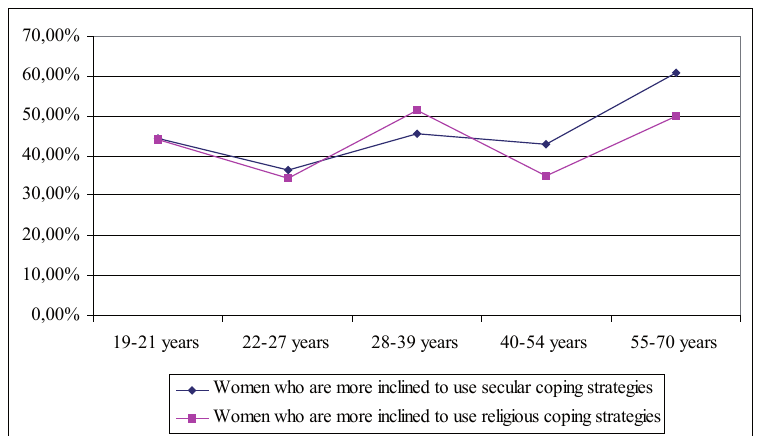
Fig. 2. Age-related dynamics of percentage division of the number of women who tend to use coping